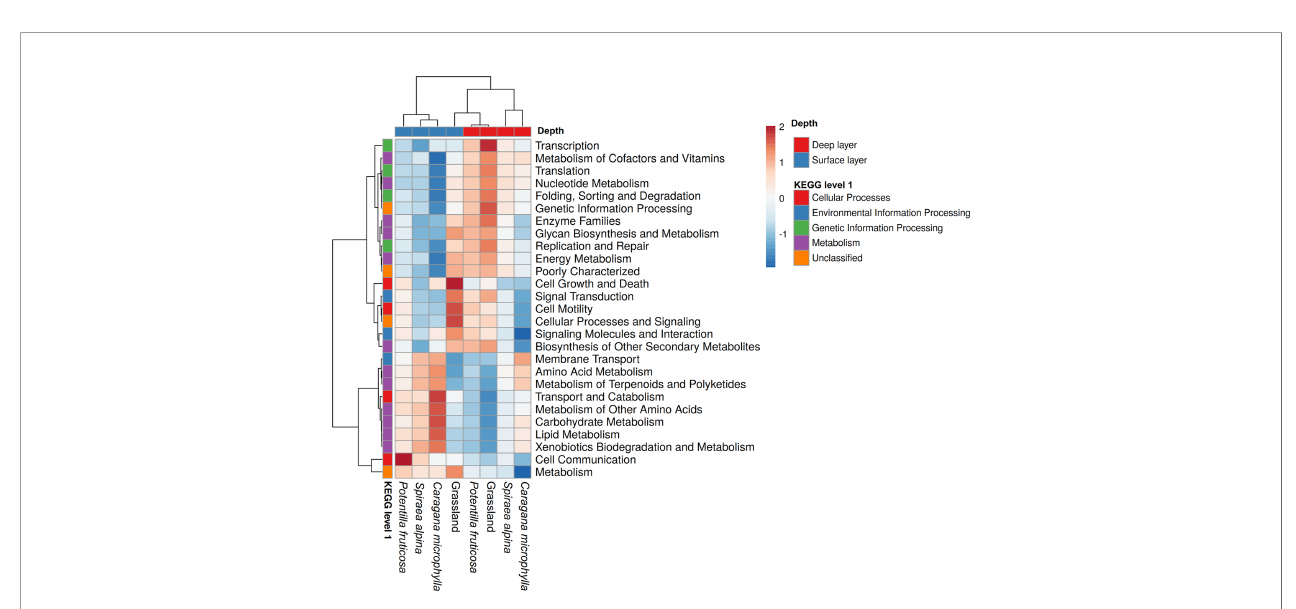
FIGURE 9 | The metabolic function of bacterial communities in the shrub and grassland patches predicted by